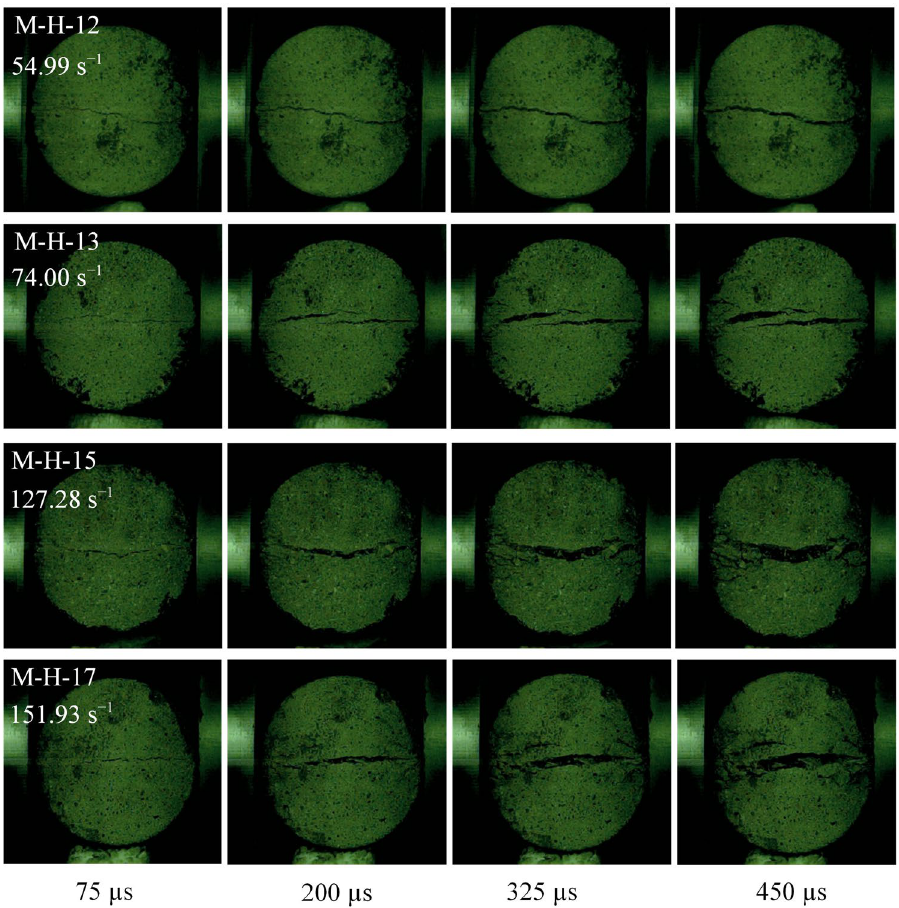
Figure 14. Failure process in mortar BD specimens with a thickness of 55 mm under different strain